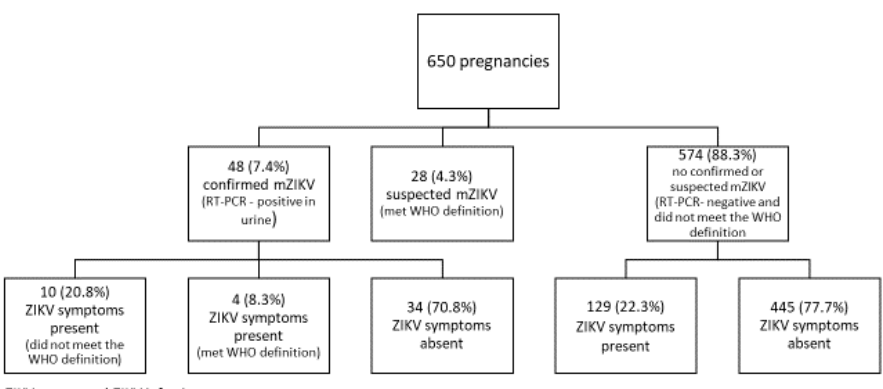
Figure 2. Distribution of pregnant women according to the WHO ZIKV case